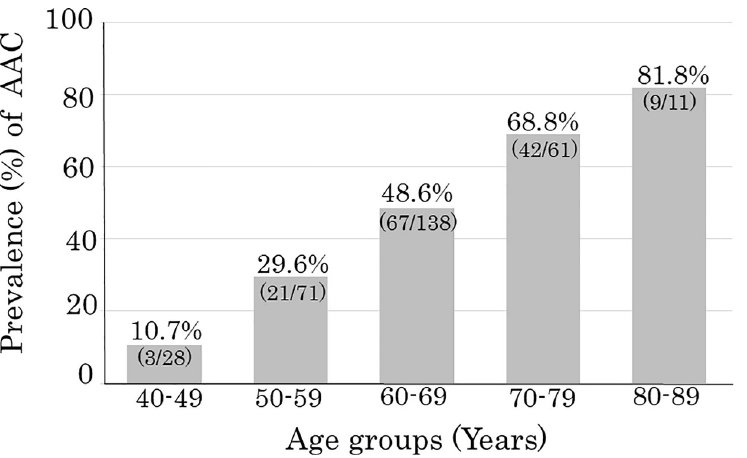
Fig 4. Percentage (%) of abdominal aortic calcification (AAC) by age group. The presence of AAC was assessed as shown in Table 1 (grades 1–3). https://doi.org/10.1371/journal.pone.0209175.g004 increased, age and prevalence of DM and carotid artery plaque also increased. The distribution of AAC-24 for all participants is shown in Fig 5. There were no significant differences in hypertension, DM, dyslipidemia, smoking, alcohol habit, %YAM and osteoporosis between patients with (n = 104) and without (n = 205) carotid artery plaque. Age (67.8 ± 7.5 vs. 61.0 ± 10.1 years, P < 0.01), male gender (56% vs. 39%, P < 0.01),